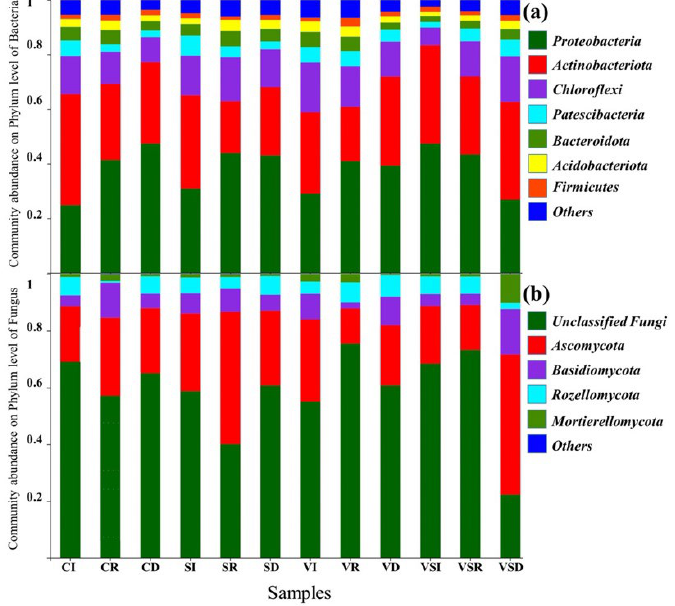
Figure 5. Community abundance at the phylum level of bacteria ( a ) and fungus ( b ). Co-composting has been widely used to adjust the initial C/N ratio. As a feedstock that was rich in nitrogen, the municipal waste of mature and sludge was mixed with litter to reduce the moisture content while promoting the C/N ratio to a proper range. During composting, the total nitrogen loss was mainly derived from the emission of NH 3 , which did cause not only odor problem and global warming, but also reduce the quality of copost by-products. Additives were effective by adsorbing NH 3 , reducing the pH of the pile and forming struvite. However, the special feature of the island depended on a bal- ance needs to be achieved between the transportation cost and the improvement effect. As for a natural additive without modification, the NH 3 emission reduction from Zeolite [34], Bentonite [35], Ceramsite [36], Phosphogypsum [37], Superphosphate [38] was 18%, 3.39%, 21%, 21.65% and 18.9%, respectively. However, the application of coral sand on the islands was cost-effective and local-sustainable. To solve, bacterial power cultivated from the compost pile could be a considerable method for a further improvement. The addition of biochar in the co-composting process of mixing pig manure with sawdust resulted in a